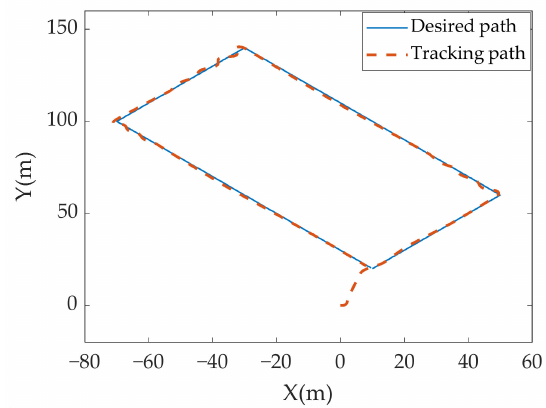
Figure 14. Tracking for the rectangular path.